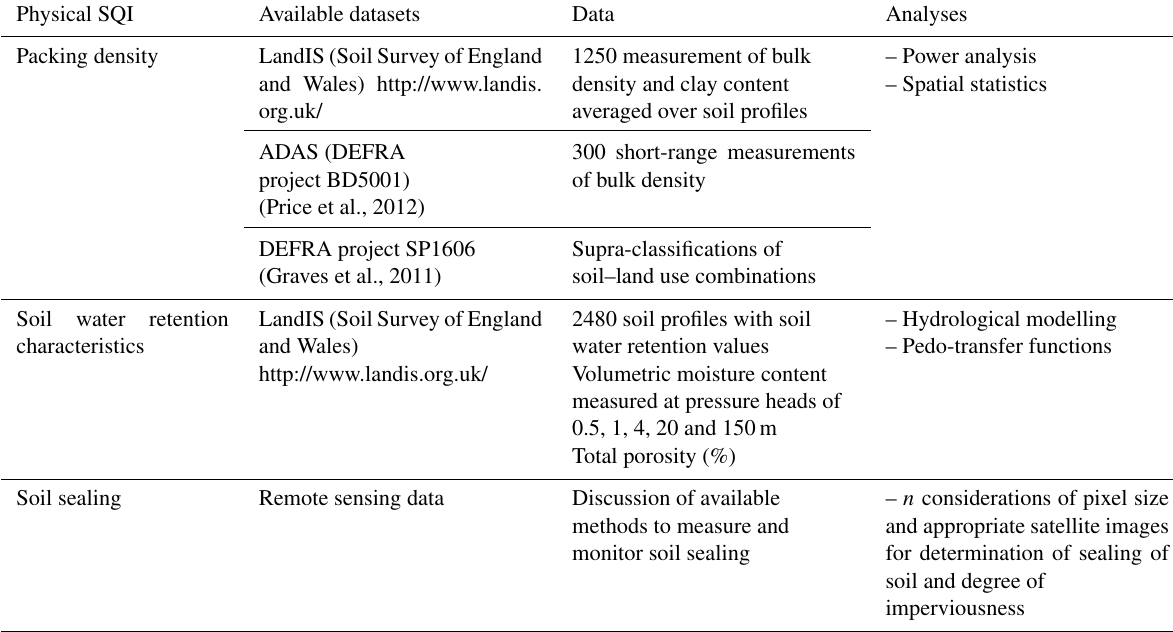
Table 1. Datasets and analyses for selected physical